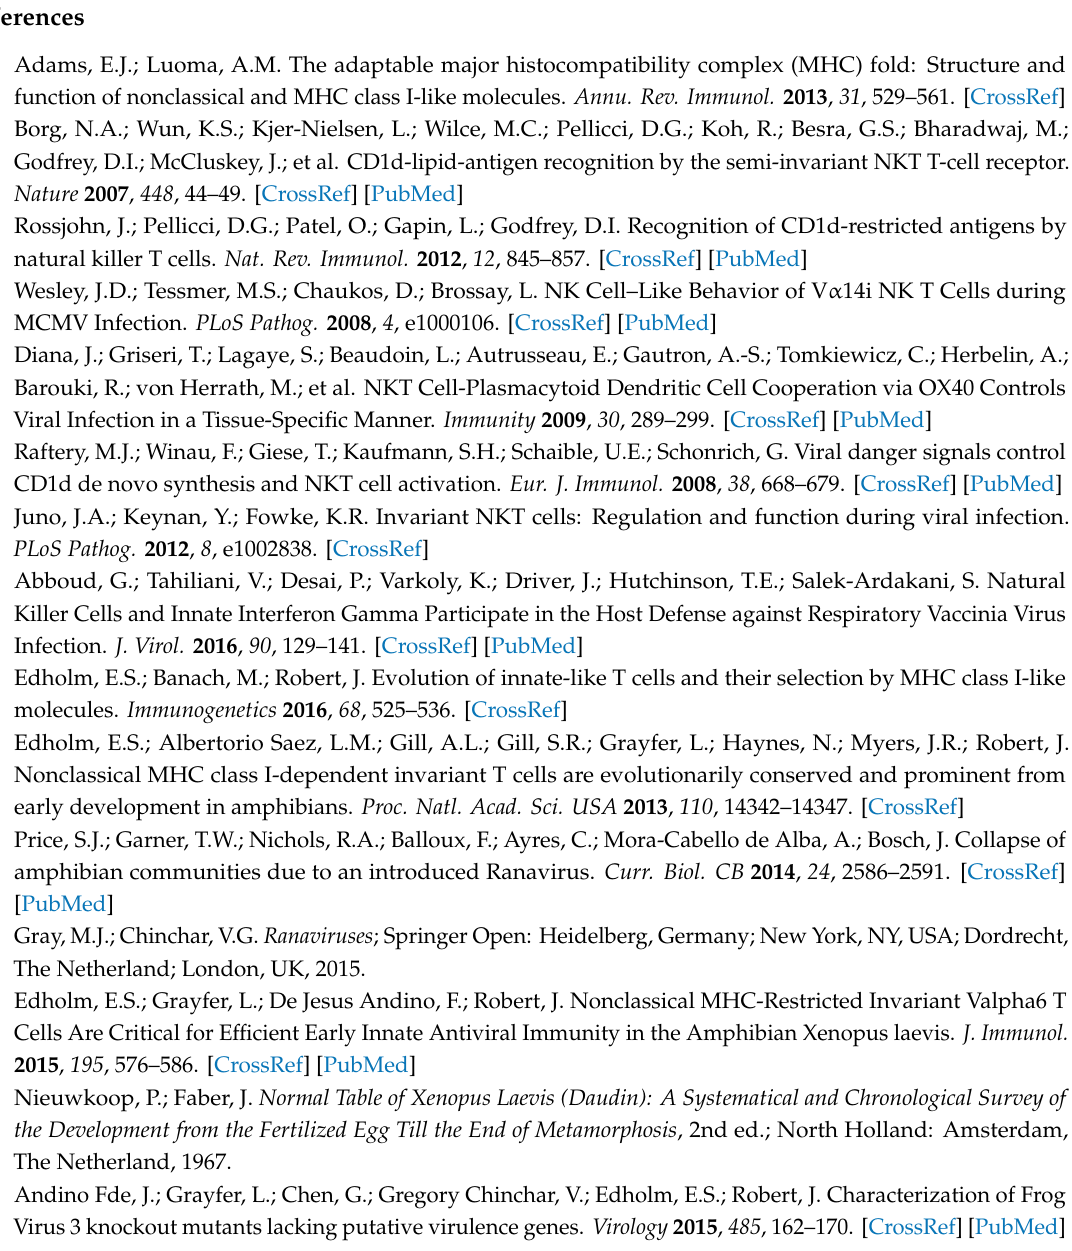
transcript levels. Table S1: List of qPCR primer sequences. Table S2: FV3 genome copy number in post-mortem tadpoles treated or not with XNC10-tetramers and infected with